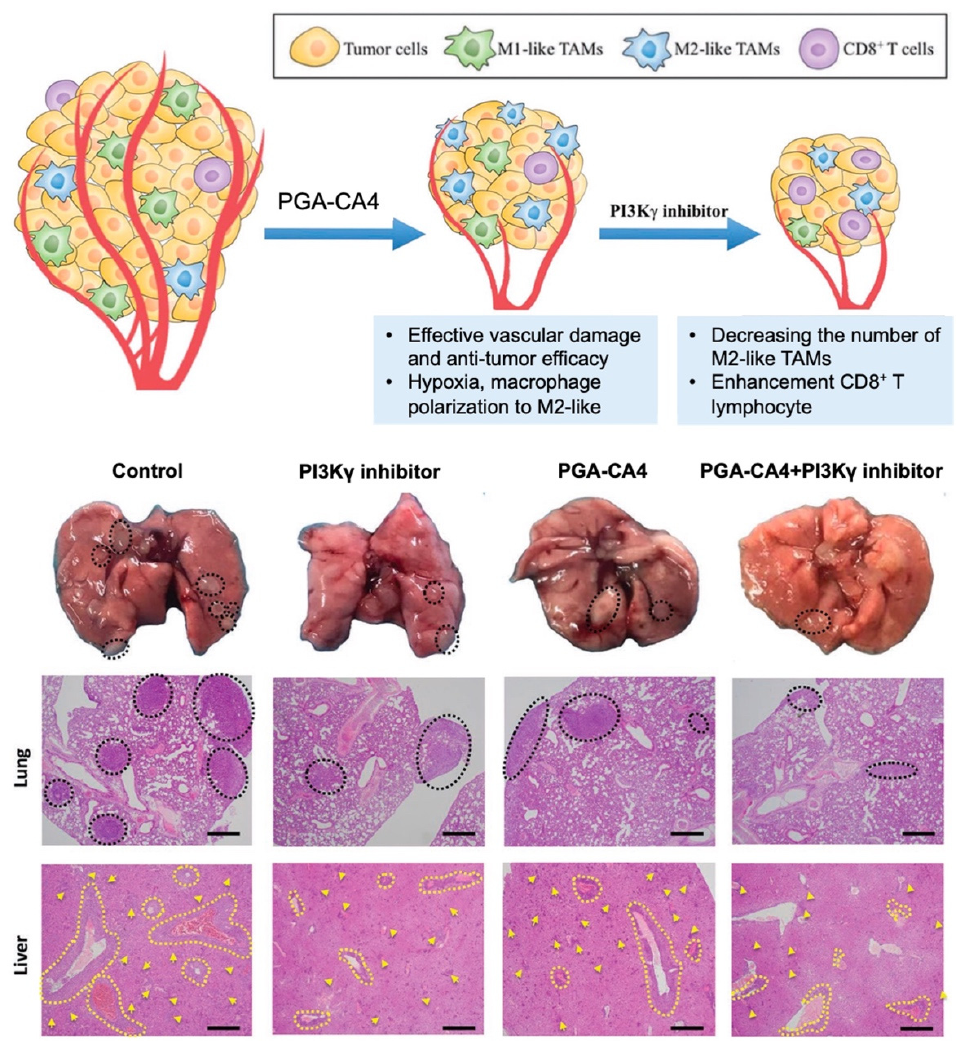
Figure 6. Reduction of the breast cancer metastasis based on PGA-CA4 in synergic with PI3K γ inhibitor. Optical photographs of lungs and H&E images of lung and liver for control and mono-/dual-prodrug treated groups. Scale bar = 500 µm. Reprinted with permission from Ref. [80]. Copyright 2019, Wiley-VCH GmbH, updated by CC 4.0.